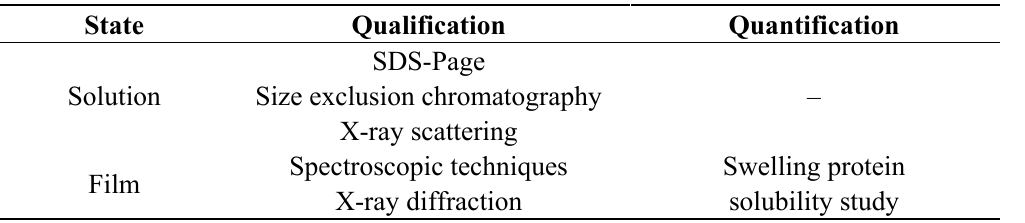
Table 5. Summary of qualification and quantification methods mentioned in this review of molecular interactions in protein based films and